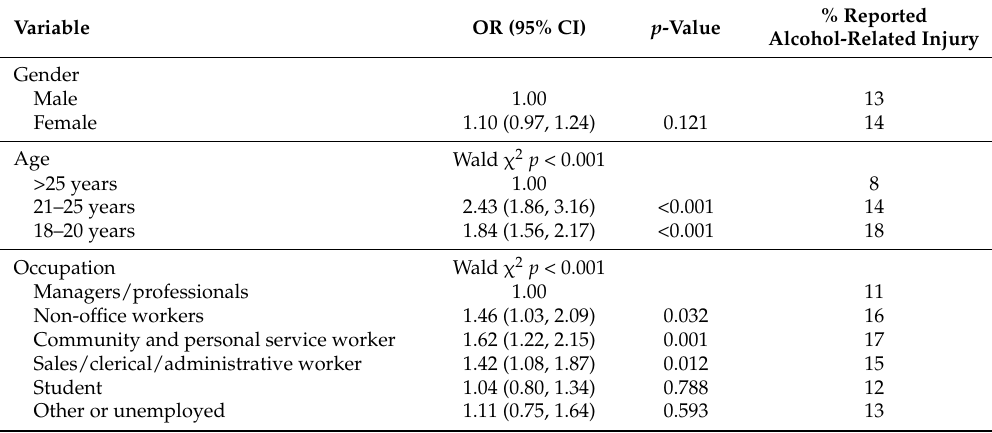
Table 2. Multivariate logistic regression models examining demographic factors associated with involvement in a non-violent alcohol-related injury in the past three months.